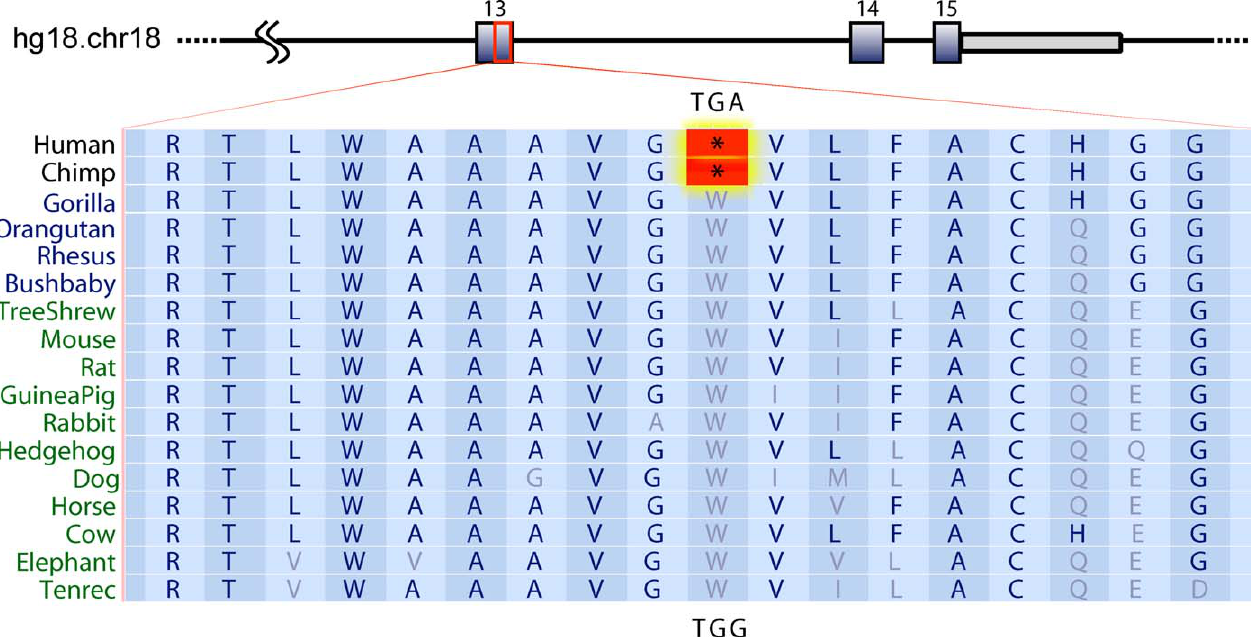
Figure 2. A Nonsense Mutation Inactivated ACYL3 During Great Ape Evolution It occurred after the divergence of gorillas from the human lineage and before the human–chimp split. The nonsense mutation is located in exon 13 of ACYL3 . A multispecies syntenic alignment showing the nonsense mutation ( ‘‘ * ’’ ) lies in a highly conserved protein coding region. The stop codon mutation (TGA) is present in the human and chimp genomes, but a TGG tryptophan (W) codon is present in the rhesus, mouse, rat, dog, and other mammalian genomes. The region maps to human Chromosome 18 at location 54,881,070–54,881,124. We sequenced the genomic region in a gorilla DNA sample to show that the codon TGG (W) codon is present in the gorilla genomes.